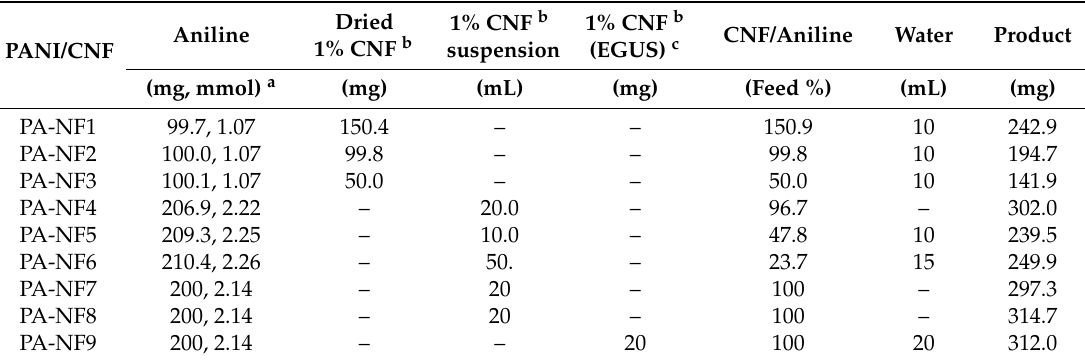
Table 1. Preparation of polyaniline/cellulose nanofiber (PANI/CNF)